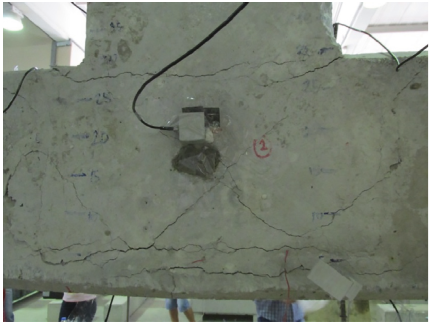
Figure 12: Failure of Sample 2.